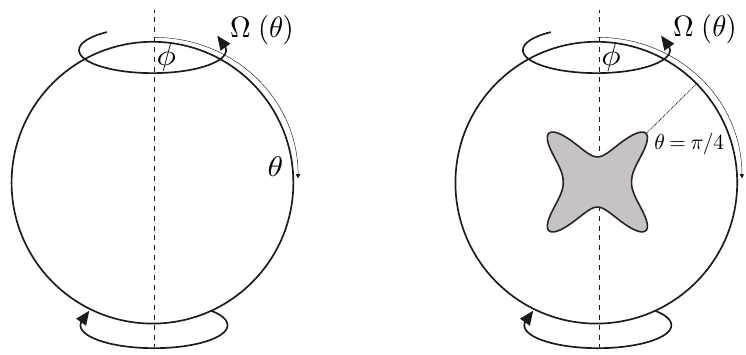
Figure 1 . Illustration of the novel AdS 4 geometries. Left : solitonic solutions with a di(cid:11)erentially rotating boundary. Right : black hole solutions. The rotational pull force is maximal at (cid:18) = (cid:25)= 4, deforming the black hole horizon into an hourglass